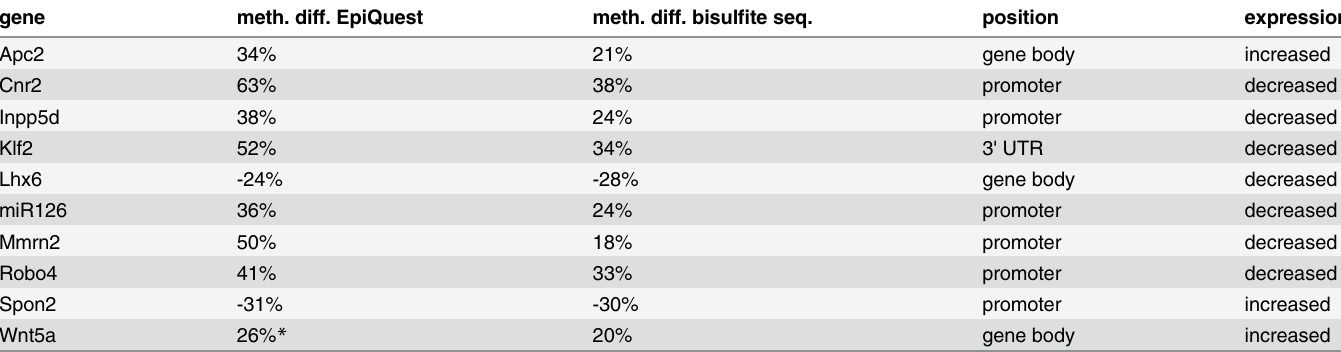
Table 2. Overview of the DNA methylation and gene expression results of 10 analyzed genes identified by EpiQuest sequencing. gene